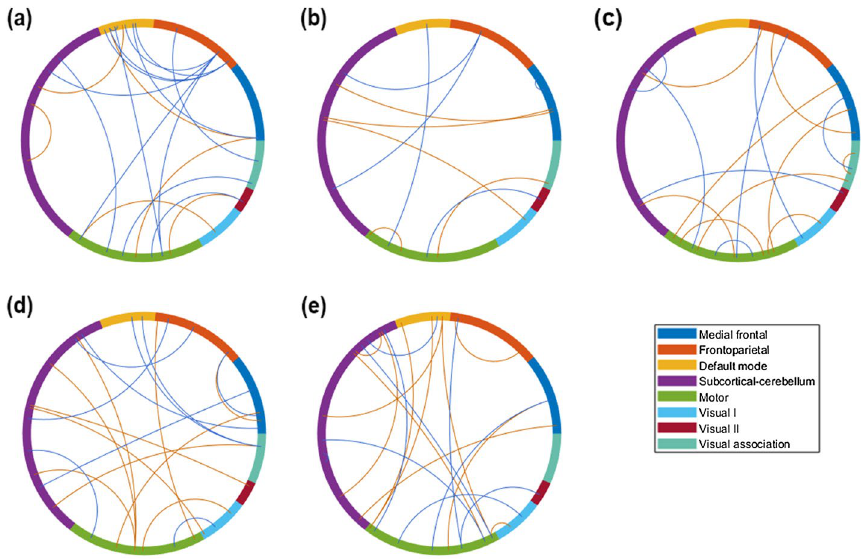
Figure 2. The major features of the classification analyses for the clinical patterns. After 100 processes of minimum redundancy maximum relevance selection with the features selected through with the threshold of the most optimal mean performance, the major features were selected over 90 times during the outer loop of the nested cross-validation. The illustration uses eight networks of Shen’s 268-region parcellation. The red lines represent the connectivity of the more occurrences group being higher than that of the fewer occurrences group, and the blue lines represent the opposite direction. ( a ) The major features of the classification for the number of episodes. ( b ) The major features of the classification based on the number of hospitalizations. ( c ) The major features of the classification based on suicide attempts. ( d ) The major features of the classification based on the history of psychosis. ( e ) The major features of the classification based on diagnostic subtypes. The red lines represent the connectivity of BDI being higher than that of BDII, and the blue lines represent the opposite